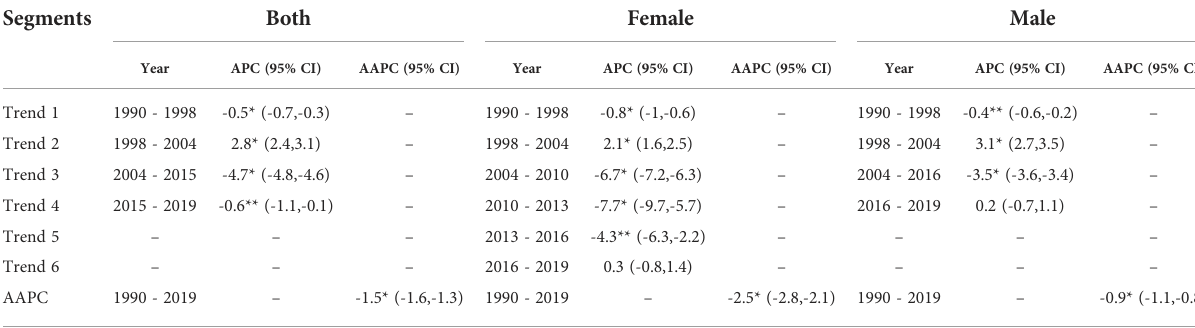
TABLE 1 Joinpoint analysis of trends in age-standardized incidence rates (ASIR) of esophageal cancer in China, 1990 – 2019. Segments